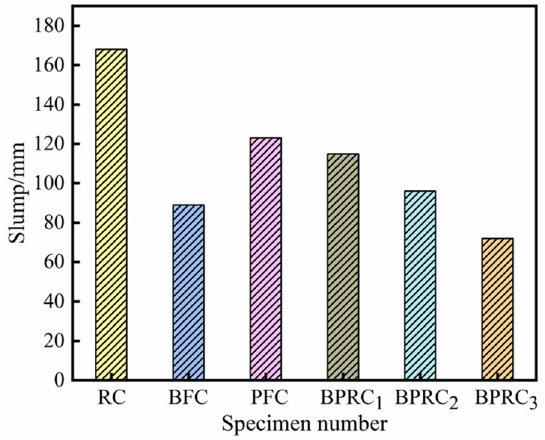
Figure 2. The slump of each group of specimens.